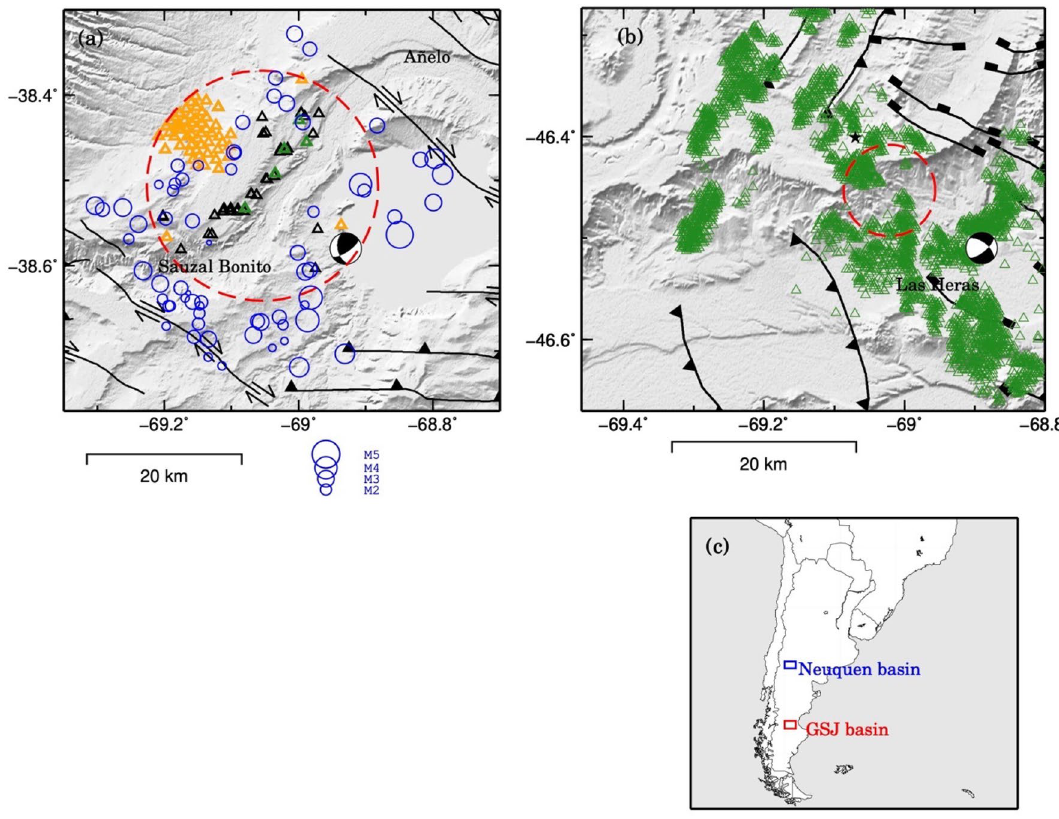
Figure 1. Study areas in the Argentinian Patagonia. Data are plotted on SRTM topography 18 displayed in shaded relief. ( a ) Neuquén basin area. Blue circles represent epicentres of seismic events scaled by local magnitude (ML) occurred in the period November 2015 to November 2020, from the Instituto Nacional de Prevención Sísmica (INPRES) catalog. The red dashed circle indicates the 15 km radius area analysed in Fig. 3a. Black triangles indicate the location of fracking wells (where unconventional hydrocarbons are extracted after slickwater injection), orange triangles indicate the location of conventional wells and green triangles indicate the location of wastewater injection wells (locations from the Argentine Energy Secretariat). Black lines indicate the main faults from 19 . The Global Centroid Moment Tensor (GCMT, www. globa lcmt. org/) focal mechanism of the 07/03/2019 earthquake (ML 4.9, Mw 5) is shown. ( b ) Golfo de San Jorge area. Green triangles represent production wells. Black lines indicate the main faults 20 . The red dashed circle indicates the 5 km radius area analysed in Fig. 7a. The Global Centroid Moment Tensor (GCMT) focal mechanism of the 17/10/2019 earthquake (ML 5, Mw 4.9) is shown. ( c ) Inset map showing the region of South America with the two study areas delineated in blue (Neuquén basin) and red (GSJ